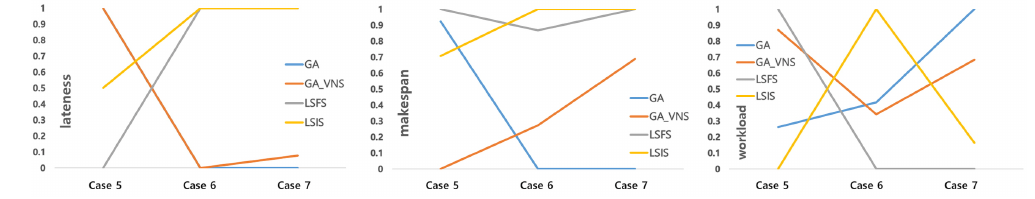
Figure 8. Comparison of optimal performance at high